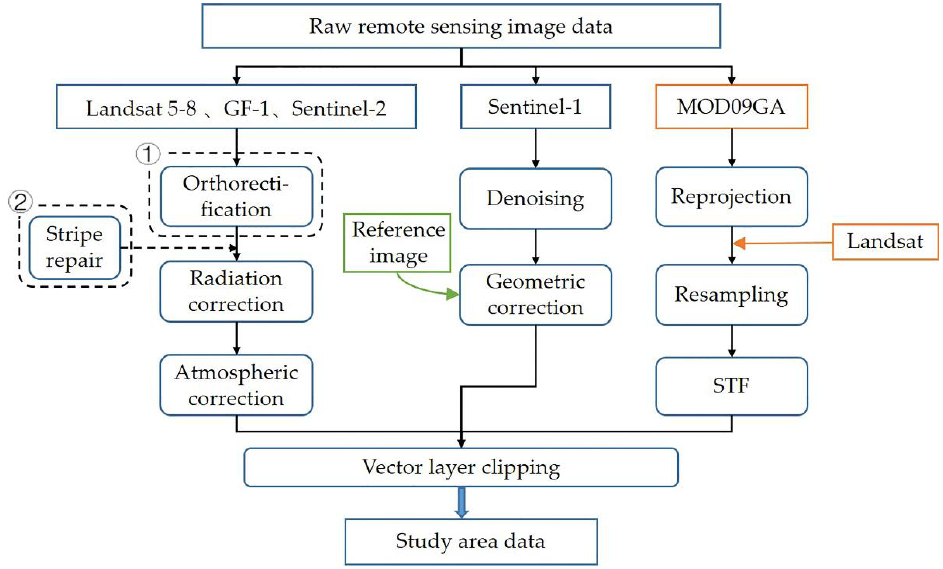
Figure 2. Preprocessing flowchart for the multiple remote sensing images.